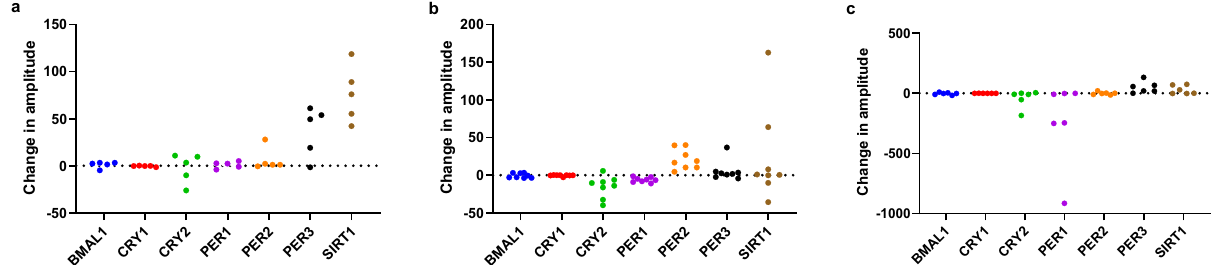
Fig. 4 TRF in fl uences the daily rhythm amplitude of clock genes expression in peripheral blood mononuclear cells. After Cosinor analysis, the amplitudes of clock gene expression in each individual were calculated. a The change in amplitude of clock genes after analyzed with Cosinor analysis in eTRF group. All participants in eTRF group showed an increase in the amplitude of SIRT1 after the trial. b The change in amplitude of clock genes after analyzed with Cosinor analysis in mTRF group. All participants in mTRF group showed an increase in the amplitude of PER2, but a decrease in that of PER1 after the trial. c The change in amplitude of clock genes after analyzed with Cosinor analysis in control